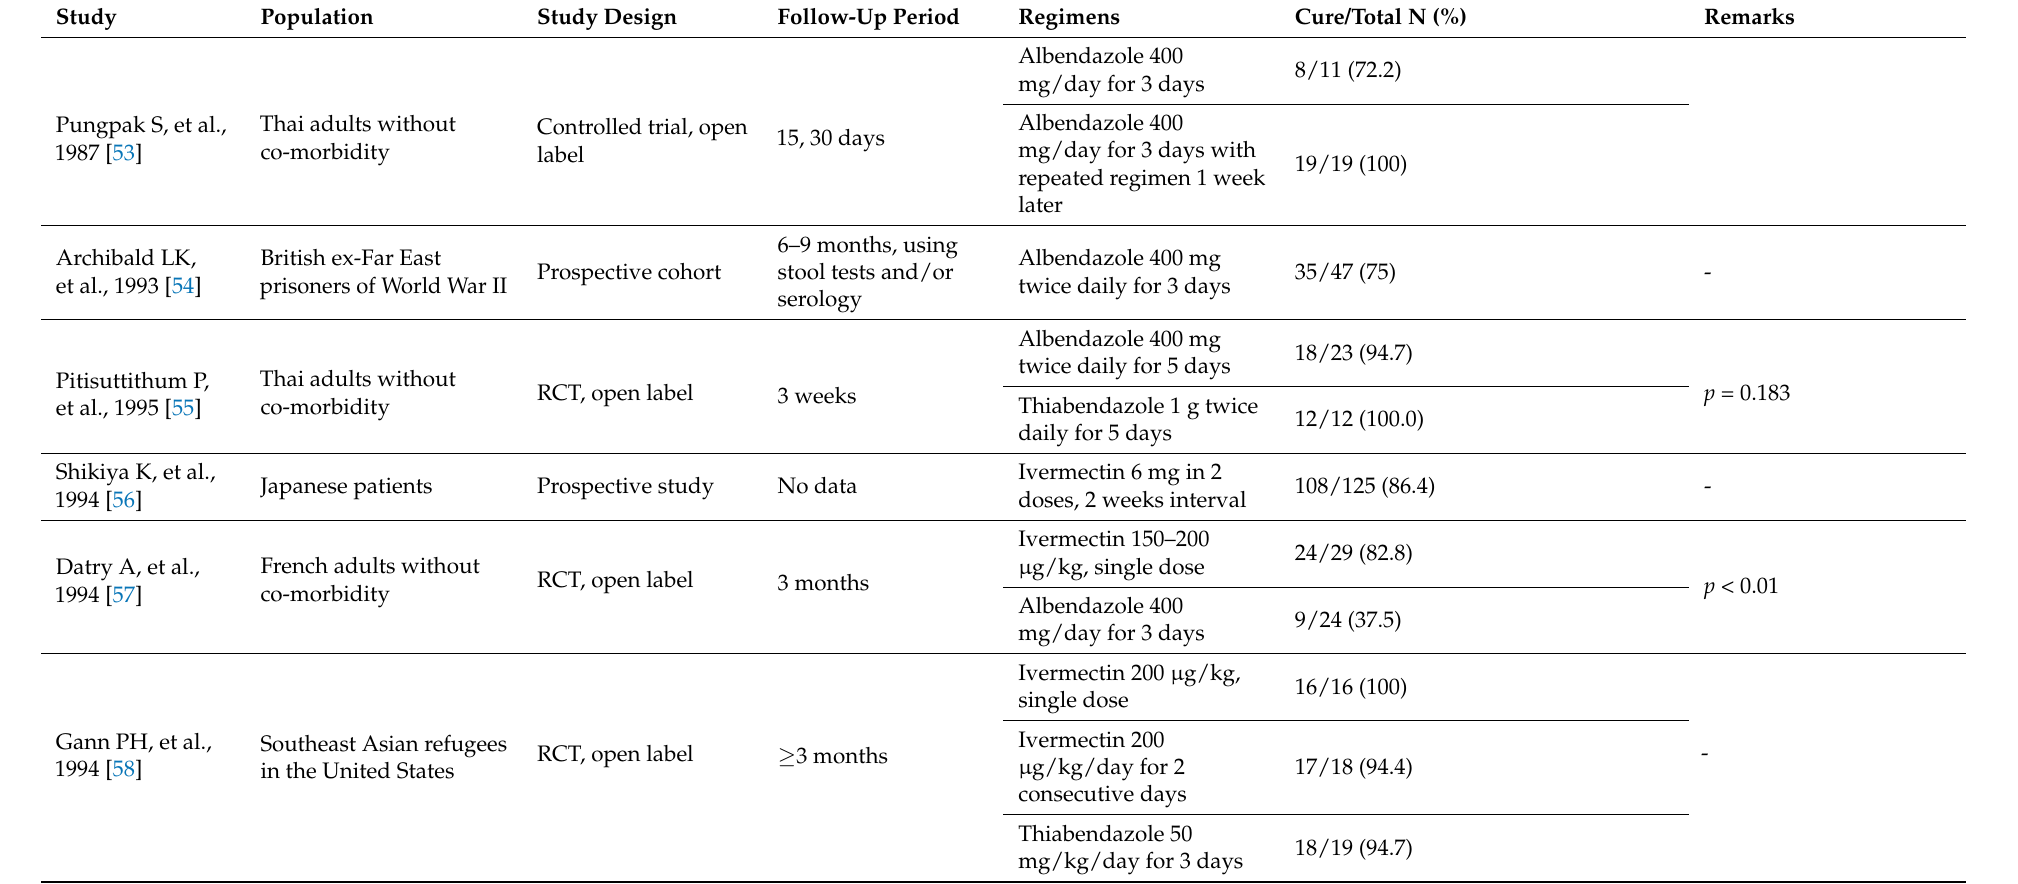
Table 2. Clinical studies in treatments of chronic uncomplicated